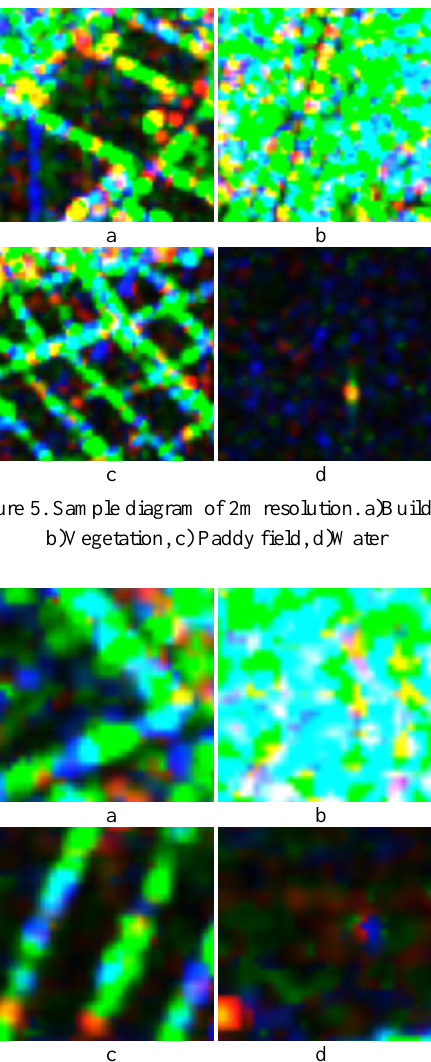
Figure 2. Model training accuracy with 2m resolution samples